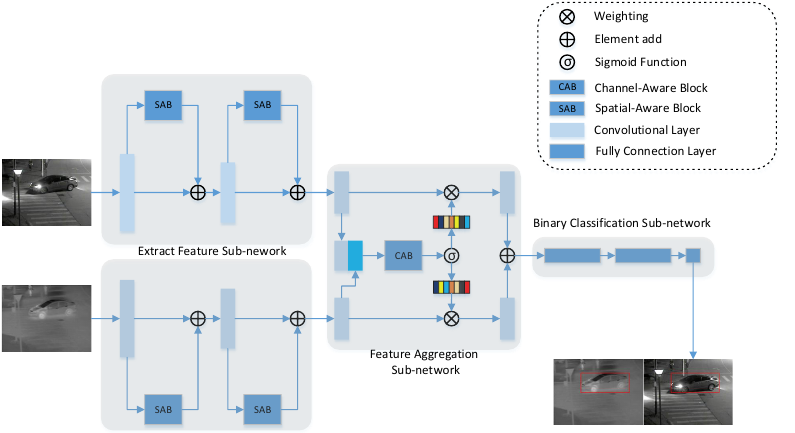
Figure 1. The overview of the proposed SCA-MMA framework for the RGB-T tracking